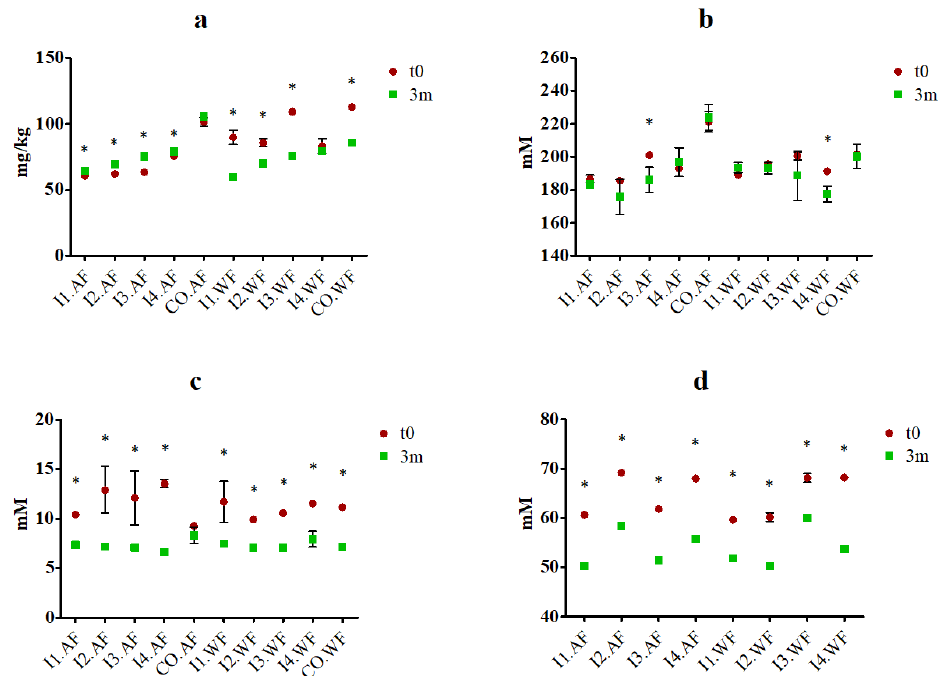
Figure 3. Free amino acids ( a ), glucose ( b ), galactose ( c ), and lactic acid ( d ) measured in fresh ice creams (t0) and after 3 months of storage (3 m). The thesis codes are as reported in Table 1: “I1.”–“I4.” prefix represents the thesis “CO.” prefix represents the negative control (without fermentation), “WF” and “AF” suffix means without and with the addition of dietary commercial fibers (5%, w / w ), respectively. Lactic acid was not found in negative control without fermentation. Data are the mean of three analytical replicates. Student’s t-test analysis was performed separately for each thesis. * is reported when values differ significantly ( p < 0.05).